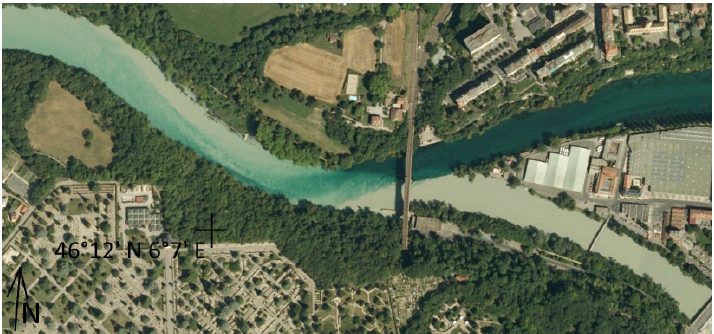
Figure 4. Aerial photograph of the Rhône-Arve confluence near Geneva (Switzerland) on 1 July 2009. Flows are from right to left. Source: Google Earth (edited).